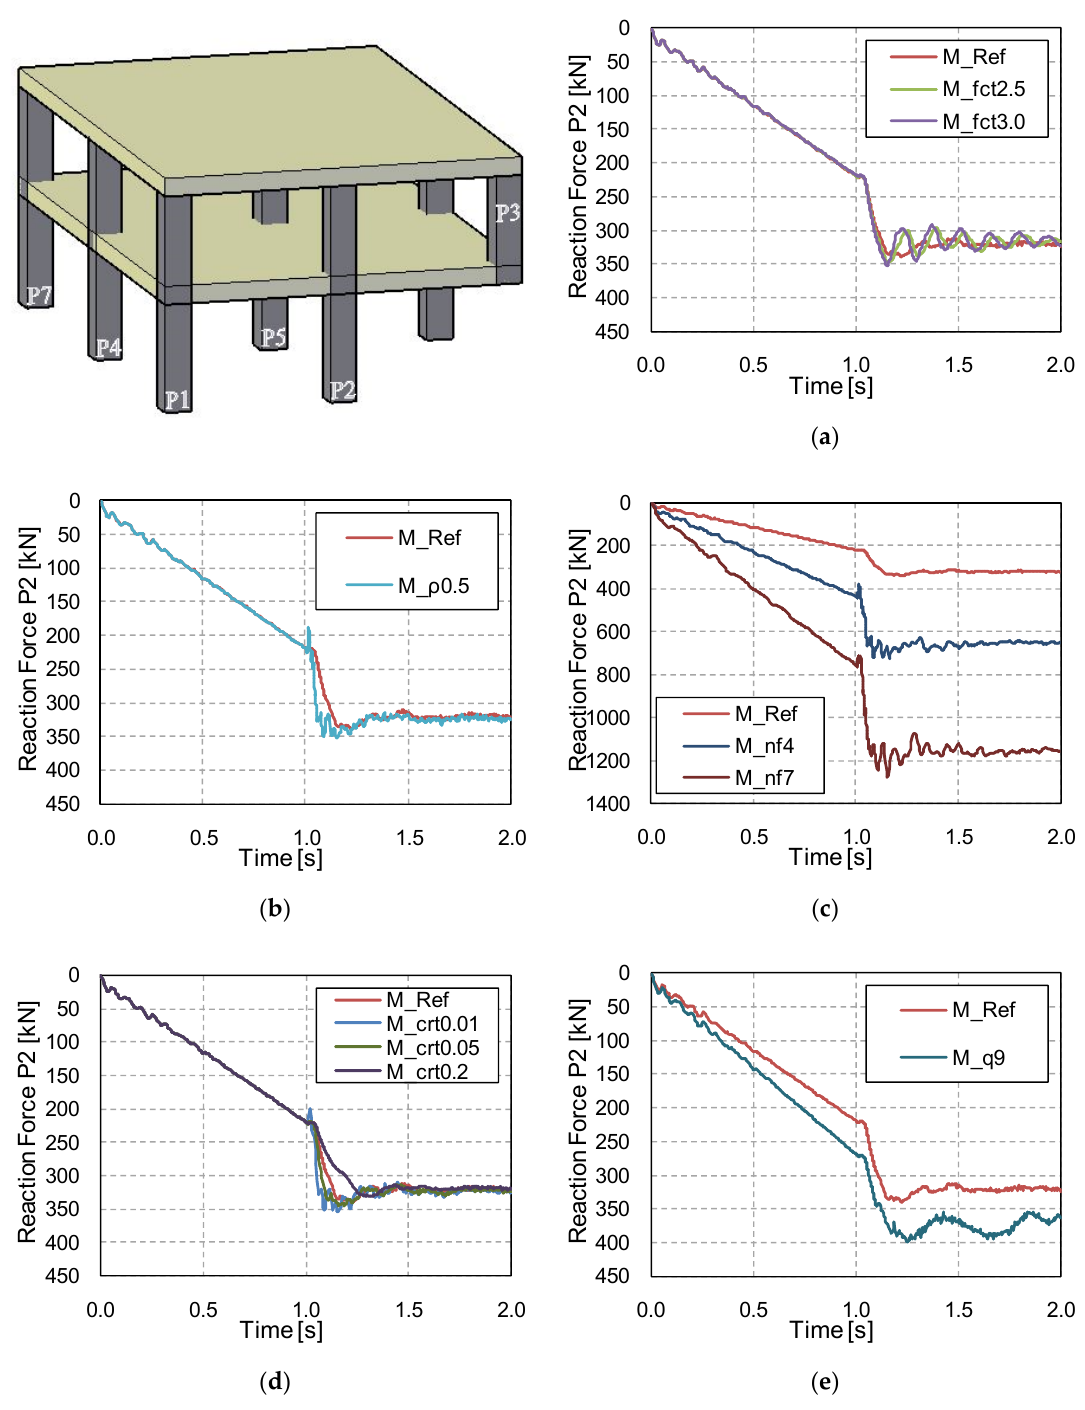
Figure 9. Numerical reaction in P2 obtained by varying ( a ) concrete tensile strength, ( b ) flexural reinforcement ratio, ( c ) number of floors, ( d ) column removal time and ( e ) superimposed load. Positive values indicate compression.